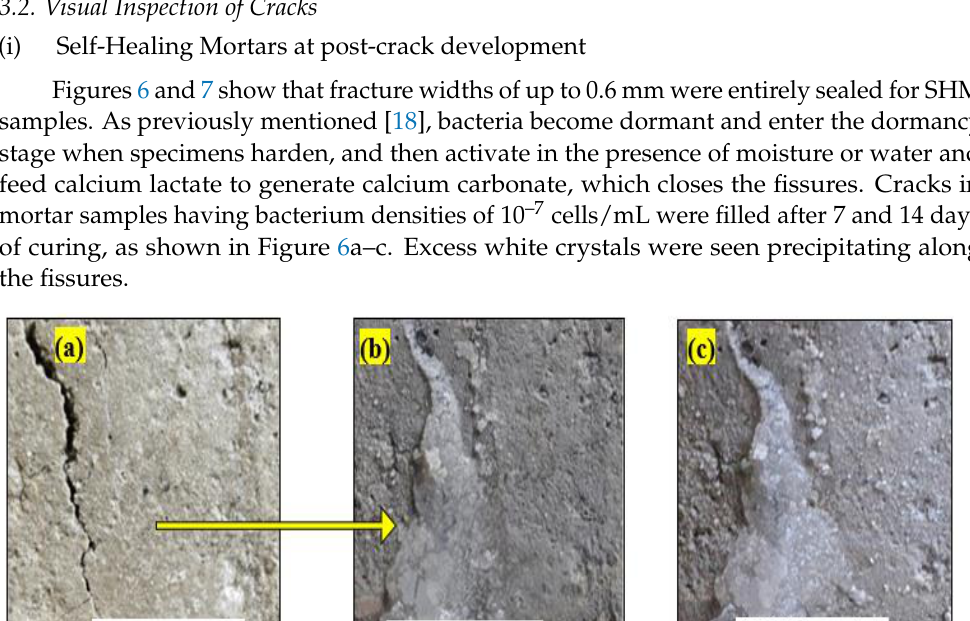
Figure 7. Healed cracks on Self-Healing Mortars with bacteria: ( a ) 10 −7 cells/mL; ( b ) 10 −9 cells/mL.